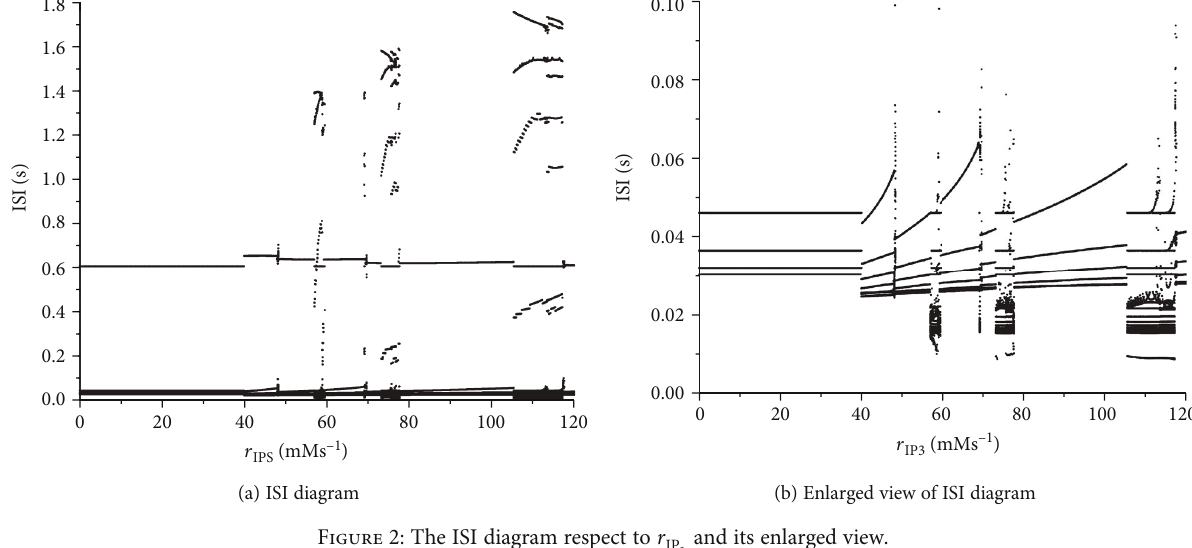
and its enlarged view. IP 3